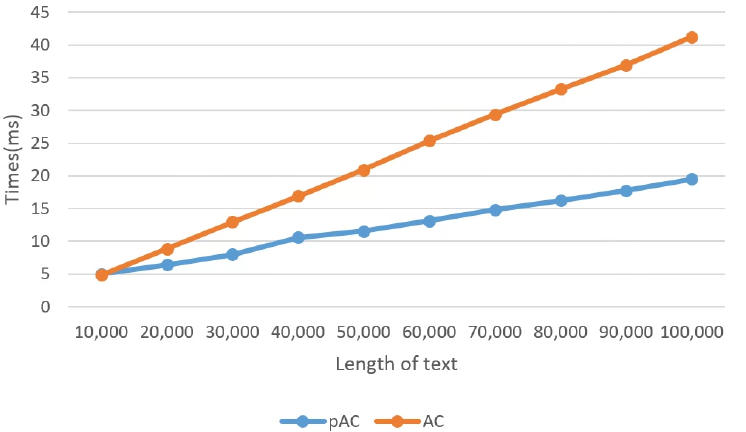
Figure 3. Comparison of execution times of AC and pAC varying n for randomly generated strings when m = 9 and k = 100.